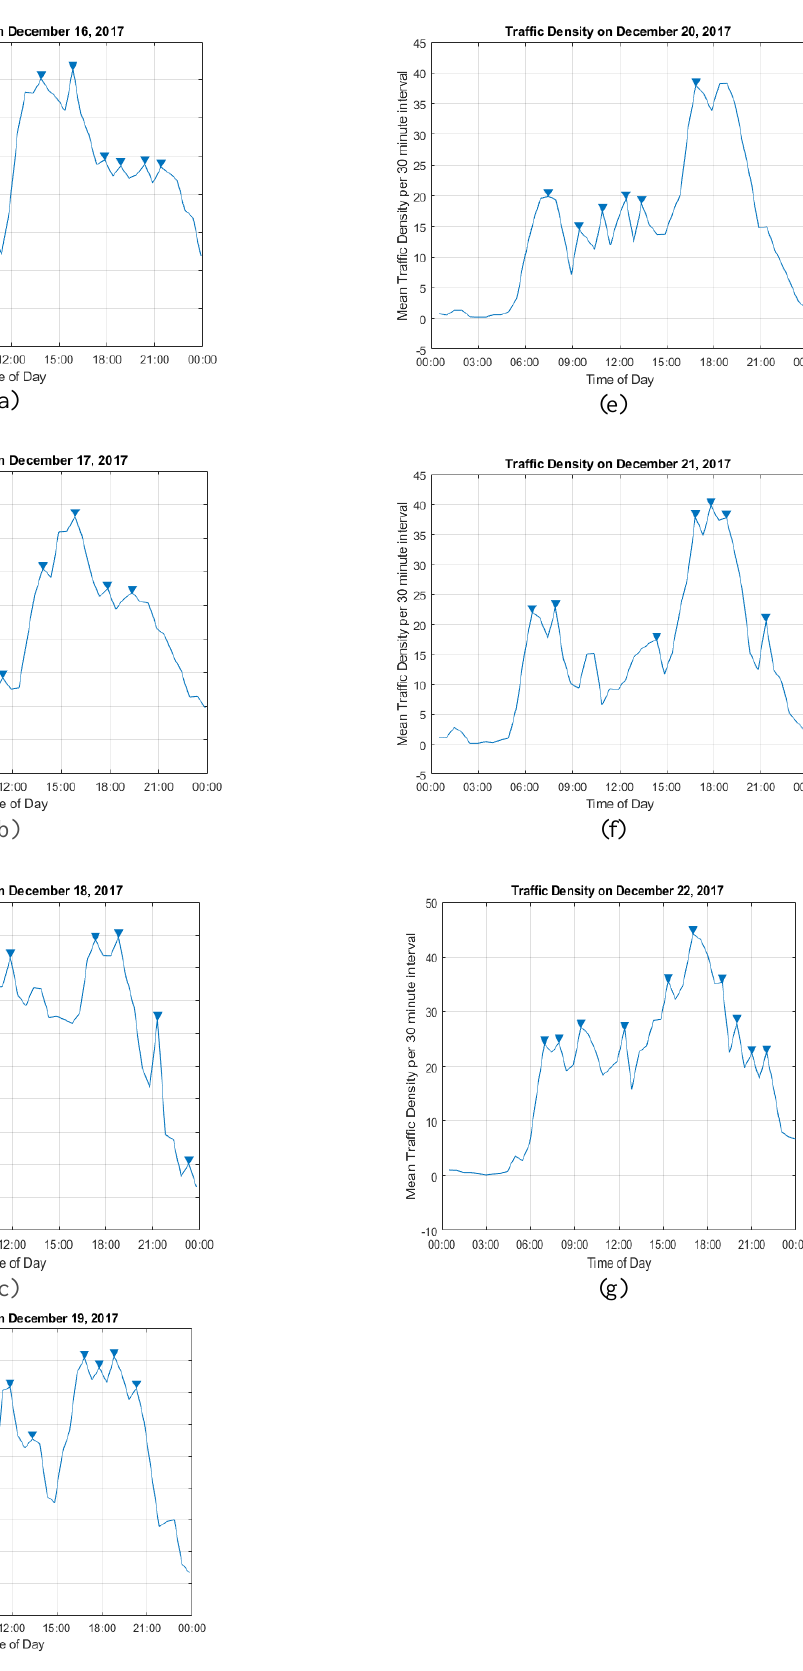
Figure 6. Traffic Density on day wise- (a). On December 16 (b). On December 17 (c). On December 18 (d). On December 19 (e). On December 20 (f). On December 21 (g). On